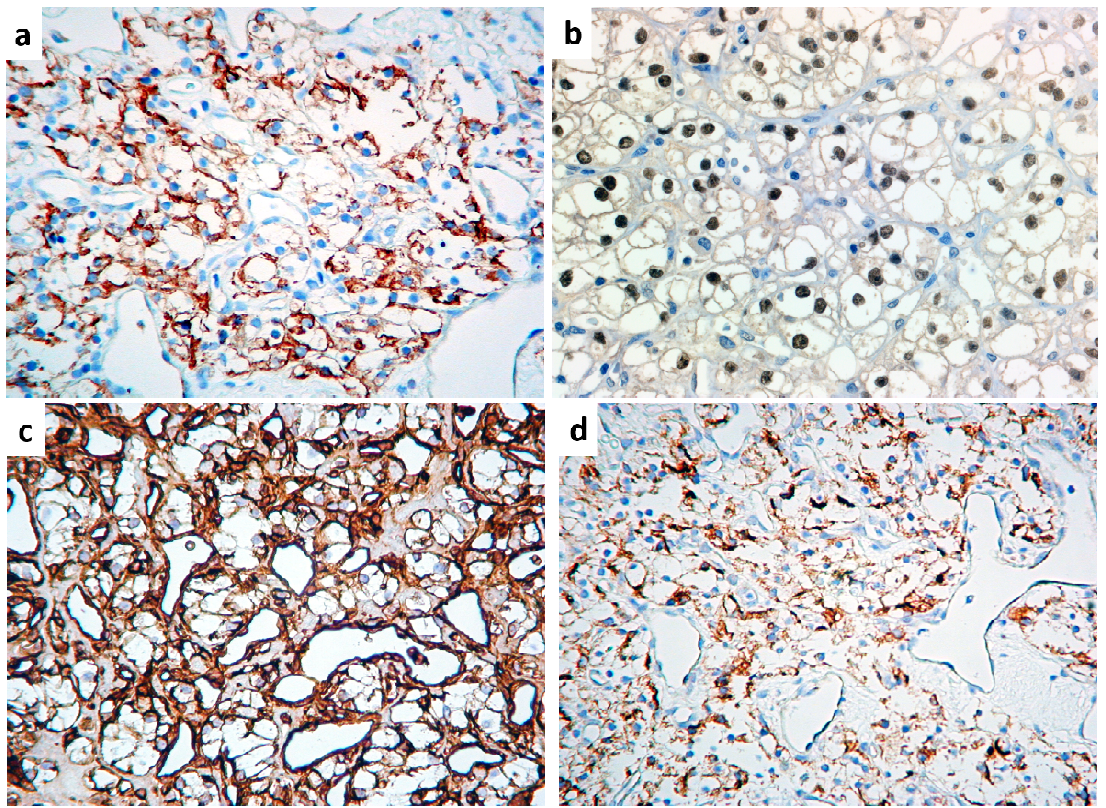
Figure 5. Immunohistochemical reactivity in clear cell renal cell carcinoma: the tumor cells display consistent positivity for ( a ) Epithelial Membrane Antigen, ( b ) PAX8, ( c ) Renal Cell Carcinoma Antigen and ( d ) CD10, allowing proper discrimination from salivary gland and odontogenic tumors. (Original magnification ×200).